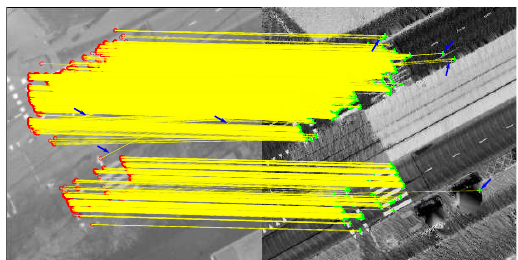
Figure 13. Correspondences computed without θ n constraint. Blue arrows are pointing toward some visible outlier correspondences.